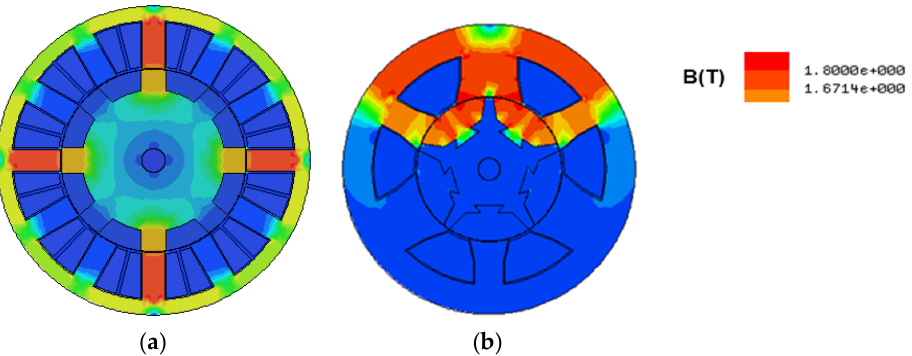
Figure 5. Magnetic flux density in the two motors. ( a ) Traditional 12/8 SRM; ( b ) Proposed 6/5 SRM.